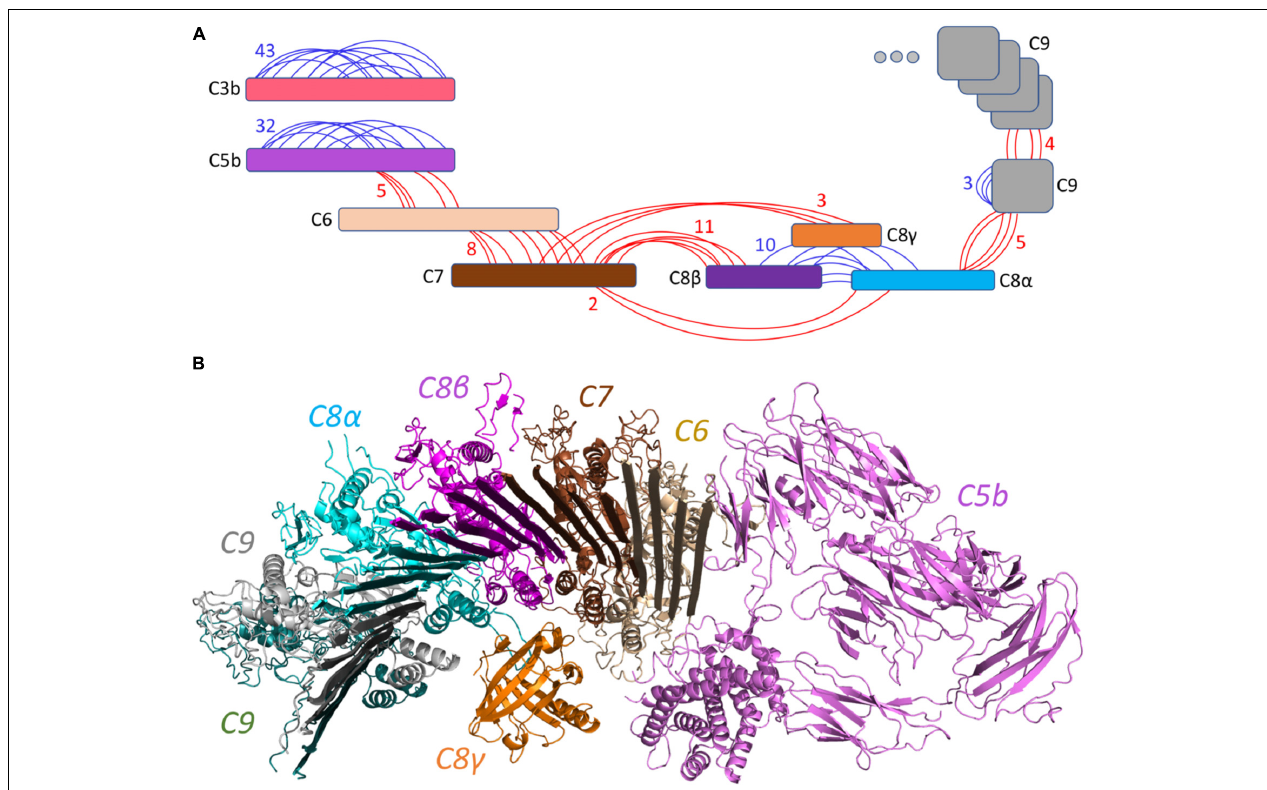
FIGURE 2 | Overview of the identified cross-linked peptides. (A) Detected XLs are indicated in red (inter-links) or blue (intra-links). A total number of 126 XLs with an estimated average of 8 links per interface were identified. (B) The generated pairwise docking models were filtered out by XL peptides and were structurally aligned together to represent the C5b–C9 complex initiating the pore by multiple C9 components. This model is supported by 38